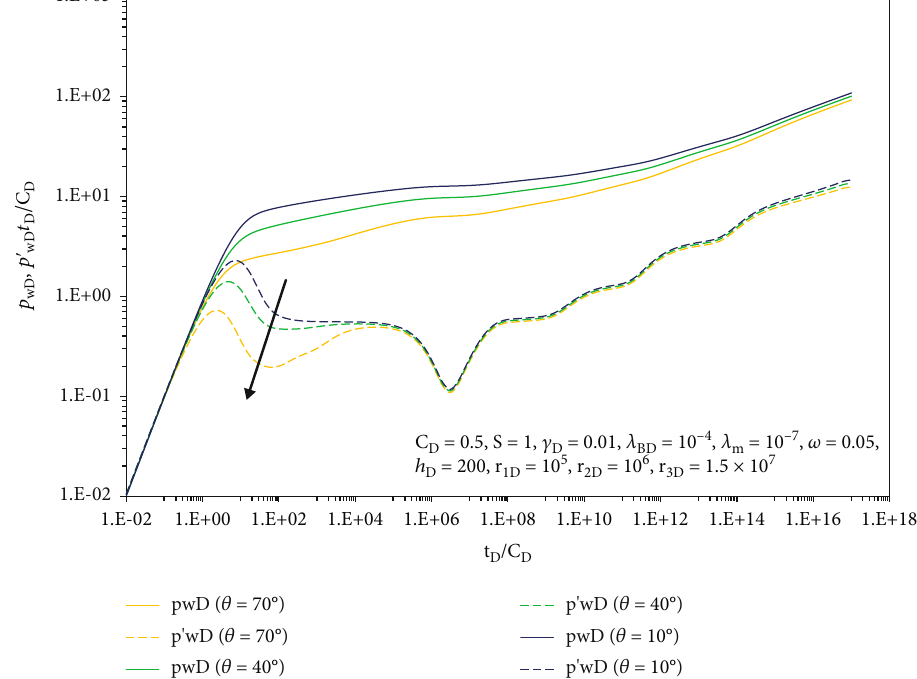
Figure 9: In fl uence of well inclination angle on pressure dynamic